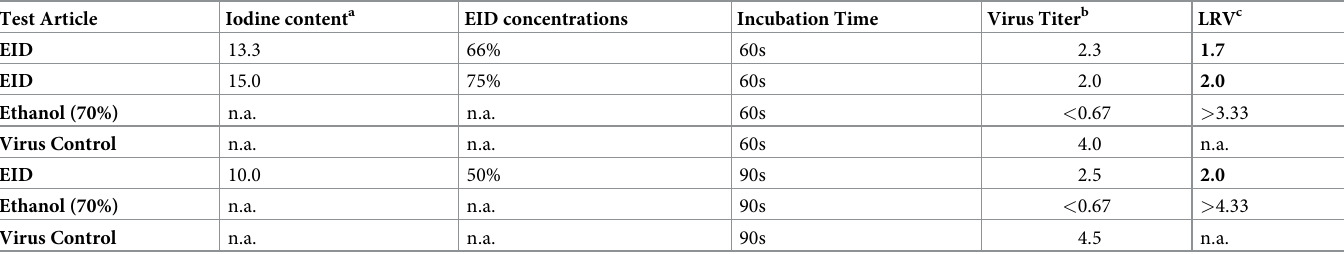
Table 1. Virucidal efficacy of Essential Iodine Drops (EID) against SARS-CoV-2 60 and 90 seconds incubation with the virus at 22 ± 2˚C.